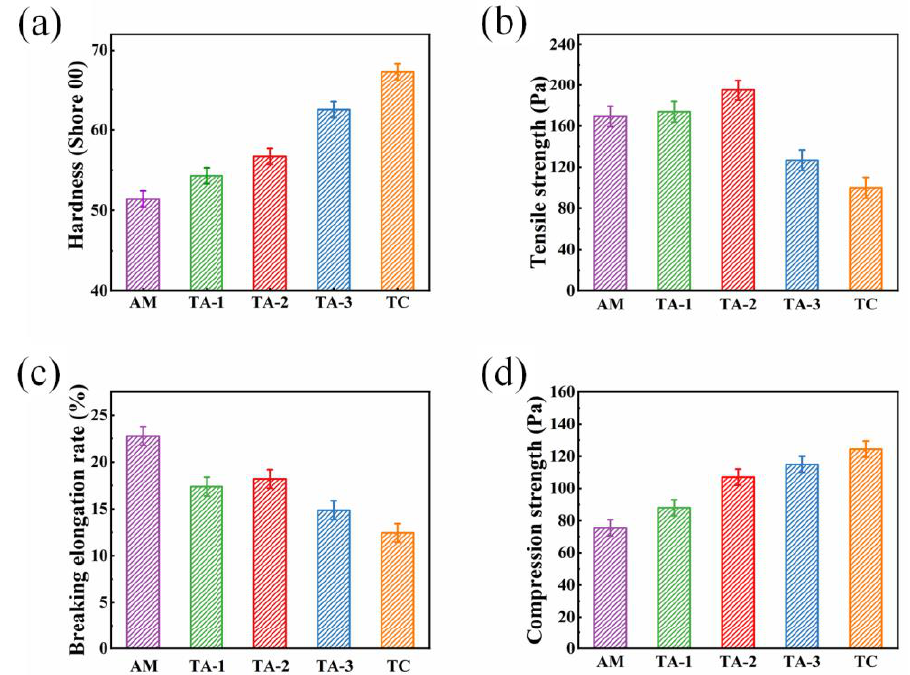
Figure 8. Mechanical properties of different composites: ( a ) hardness; ( b ) tensile strength; ( c ) breaking elongation rate; ( d ) compressive strength.